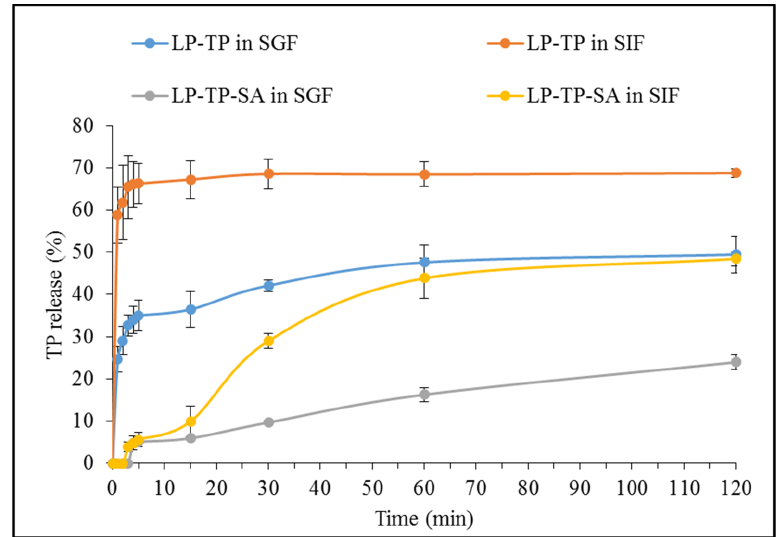
Figure 11. Dissolution profiles of TP from LP-TP and LP-TP-SA. Values expressed are means with standard deviations as error bars, n = 3.